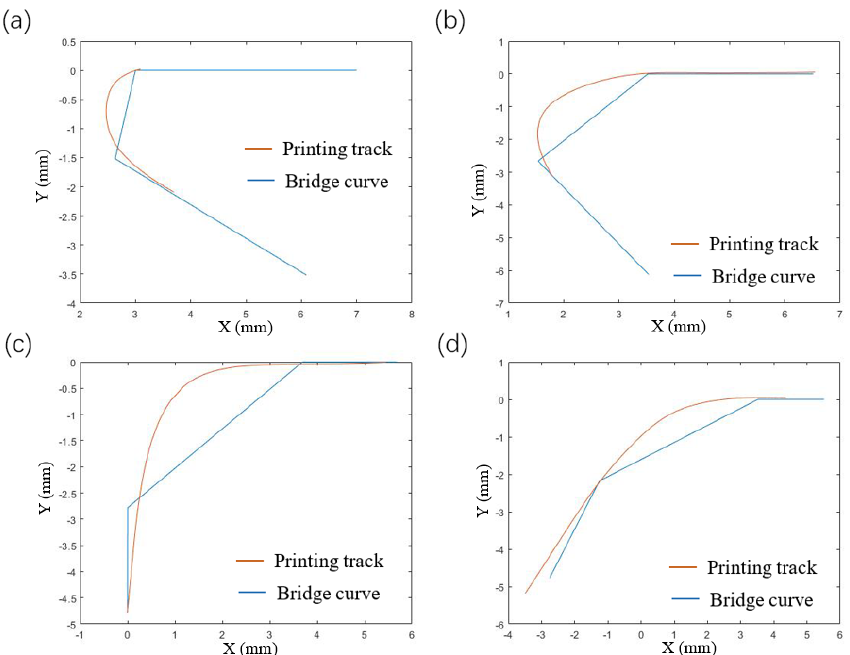
Figure 18. Simulation of removing minimum curvature points at different corners, ( a ) 30°, ( b ) 60°, ( c ) 90°, ( d ) 120°.